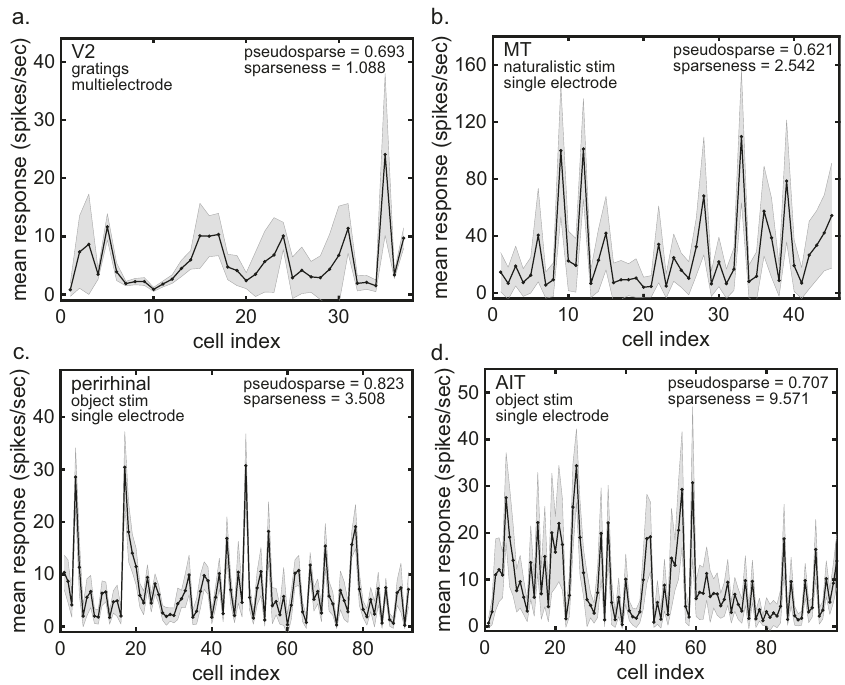
Fig. 5 Response spectra for four extrastriate cortical areas using a variety of stimuli. a Response spectrum from V2. N = 37 neurons with 8 stimuli per neuron (Data from Zandvakili and Kohn 32 and Semedo et al. 33 ). b Response spectrum from MT. N = 45 neurons with 200 stimuli per neuron (Data from Nishimoto and Gallant 36 ). c Response spectrum from perirhinal cortex. N = 92 neurons with n = 110 stimuli per neuron (Data from Lehky and Tanaka 37 ). d Response spectrum from anterior inferotemporal cortex (AIT). N = 122 neurons with n = 110 stimuli per neuron (Data from Lehky and Tanaka 37 ). Gray error bars represent standard